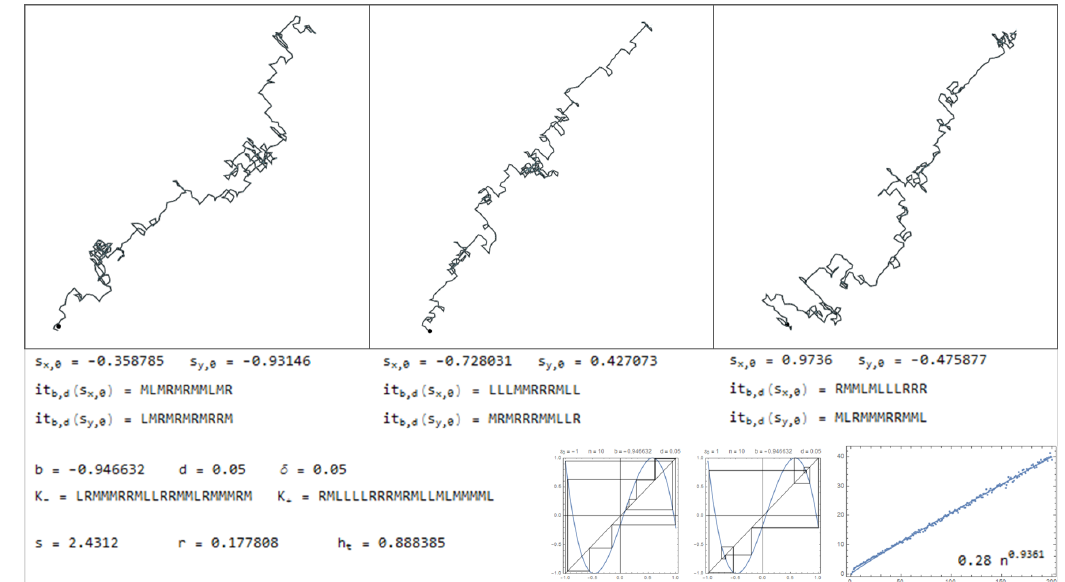
Figure 27. Trajectories produced with b = − 0.946632 and d =